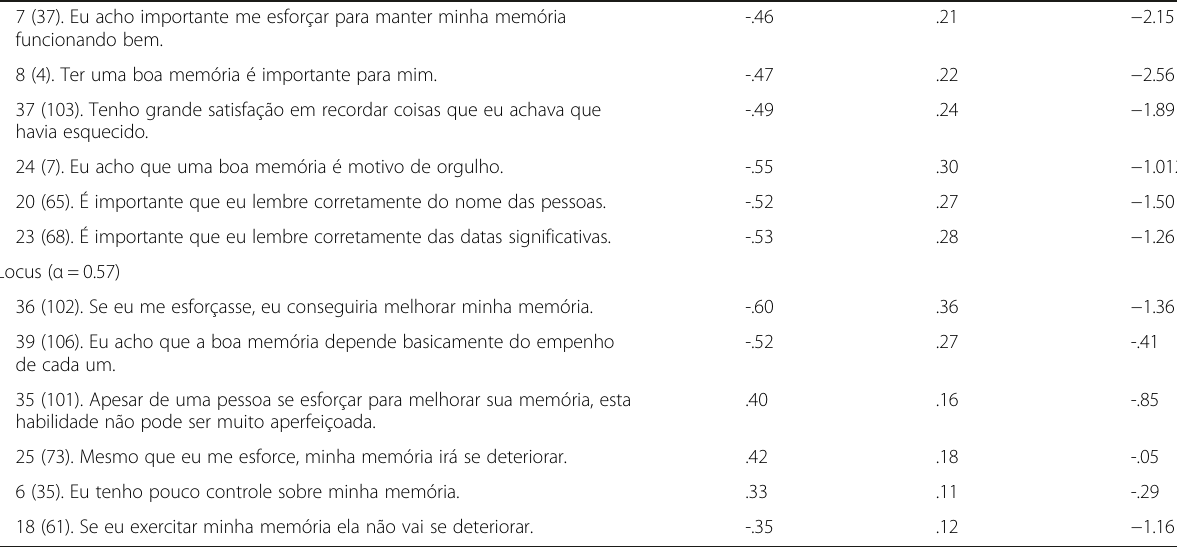
Table 2 Items factor loadings, communalities and difficulty for each subscale of the MIAr (Continued)